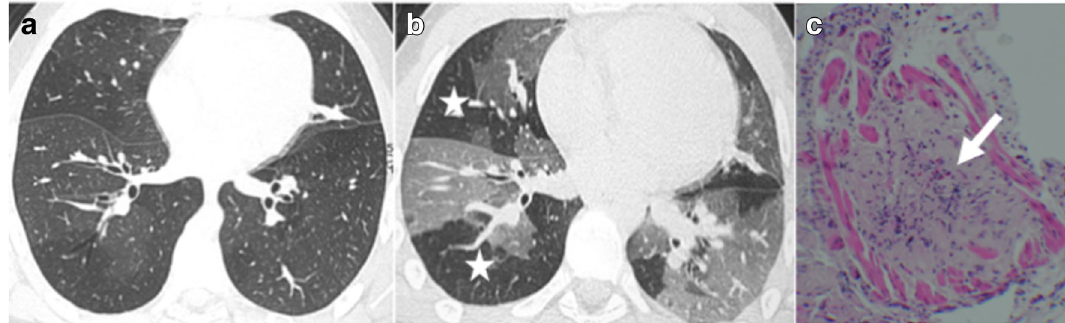
Fig. 11 BOS. Chronic dyspnea and cough. Normal parenchyma on inspiration acquisition ( a ) followed by air-trapping on expiration acquisition ( stars ) ( b ) in constrictive bronchiolitis, characterized by submucosa fibrosis ( arrow ) ( c